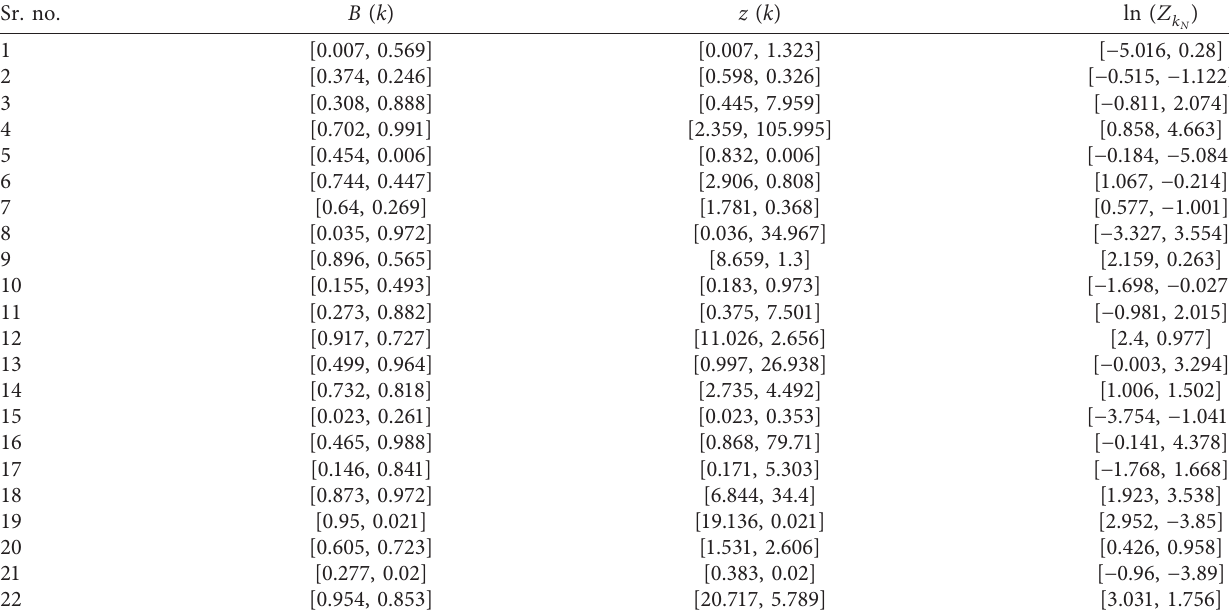
Table 6: The simulated data for the proposed control chart.